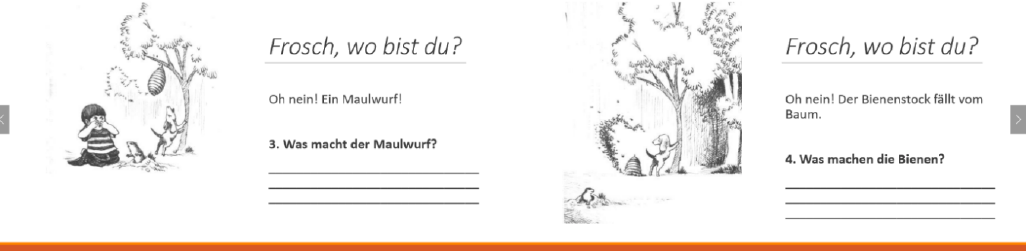
Figure A6. Pretest: Production task.